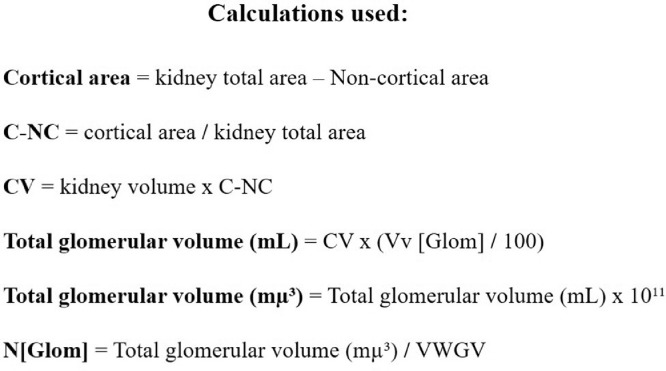
Calculations Used.